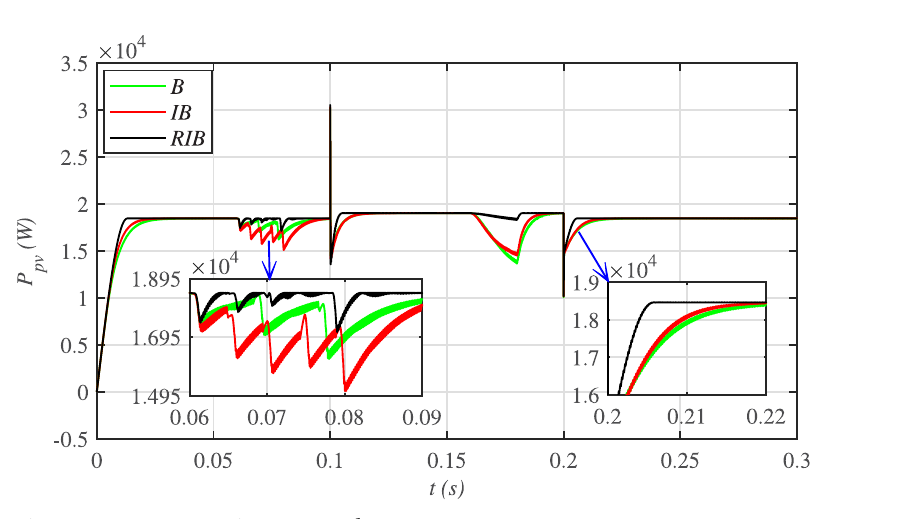
Fig 18. PV array comparative powers under case 2.